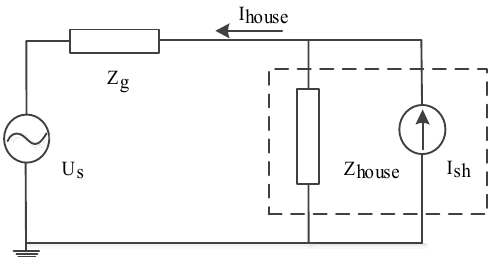
Figure 4. Equivalent circuit model for a